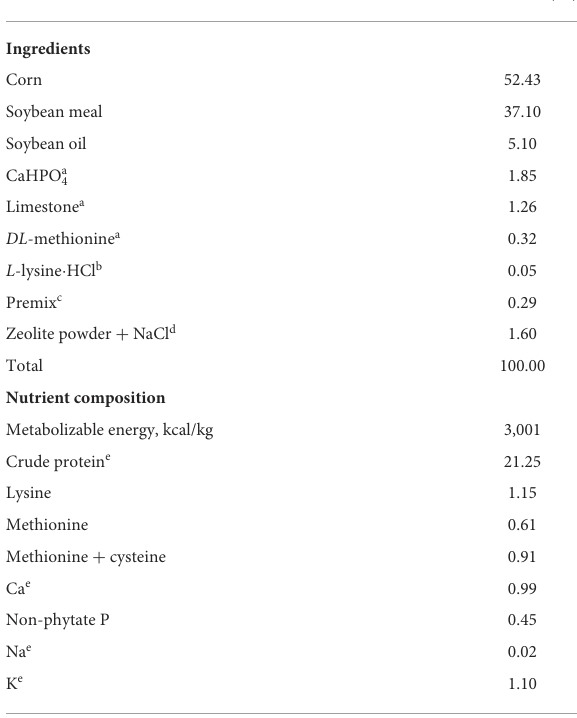
TABLE 1 Composition and nutrient levels of the basal diet from 1 to 21 days of age (as-fed basis).